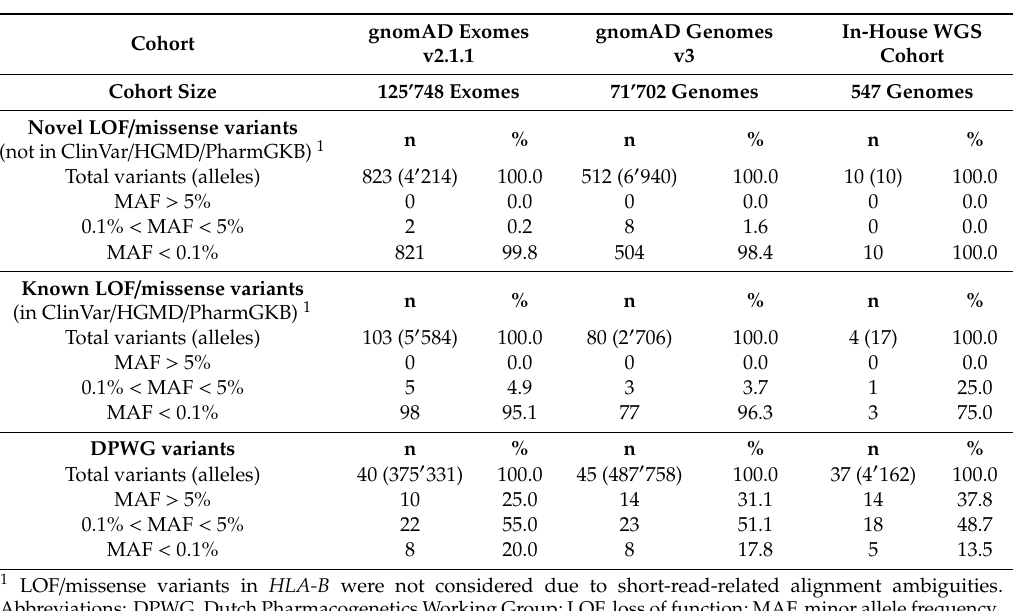
Table 1. Number (n) and proportions (%) of DPWG pharmacogene variants detected in gnomAD and our in-house WGS cohort.